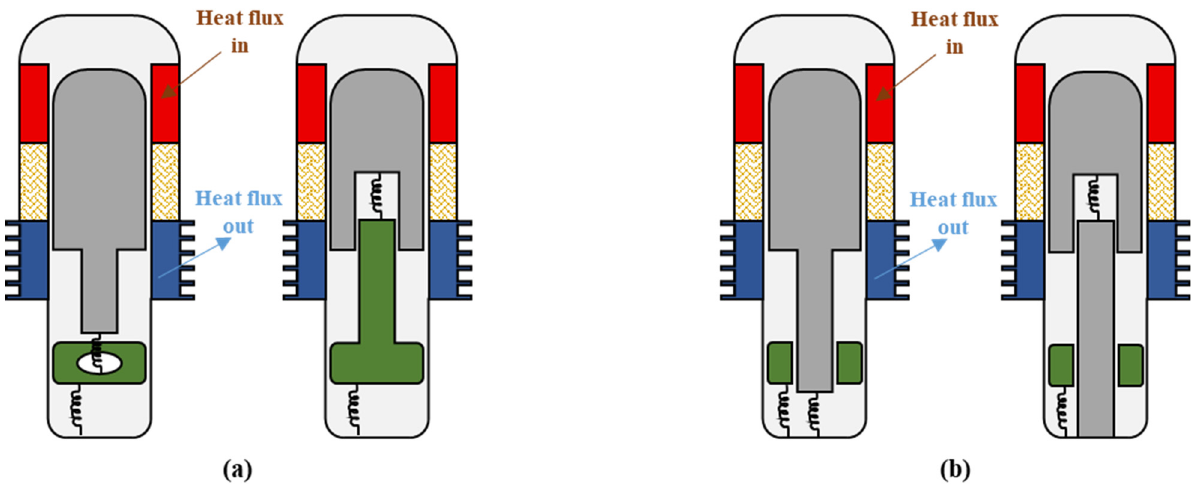
Figure 3. Two common models of single-acting working piston-displacer in tandem FPSE: ( a ) displacer sprung to working piston; ( b ) displacer piston sprung to ground.